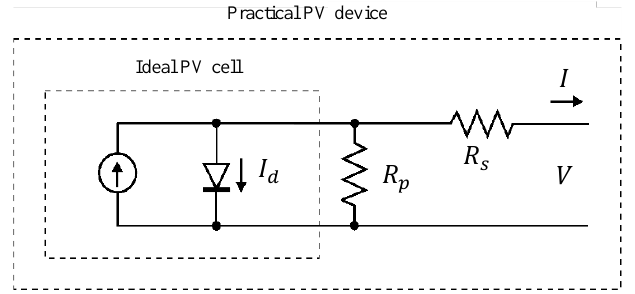
Figure 2. Equivalent circuit of a single diode photovoltaic (PV)